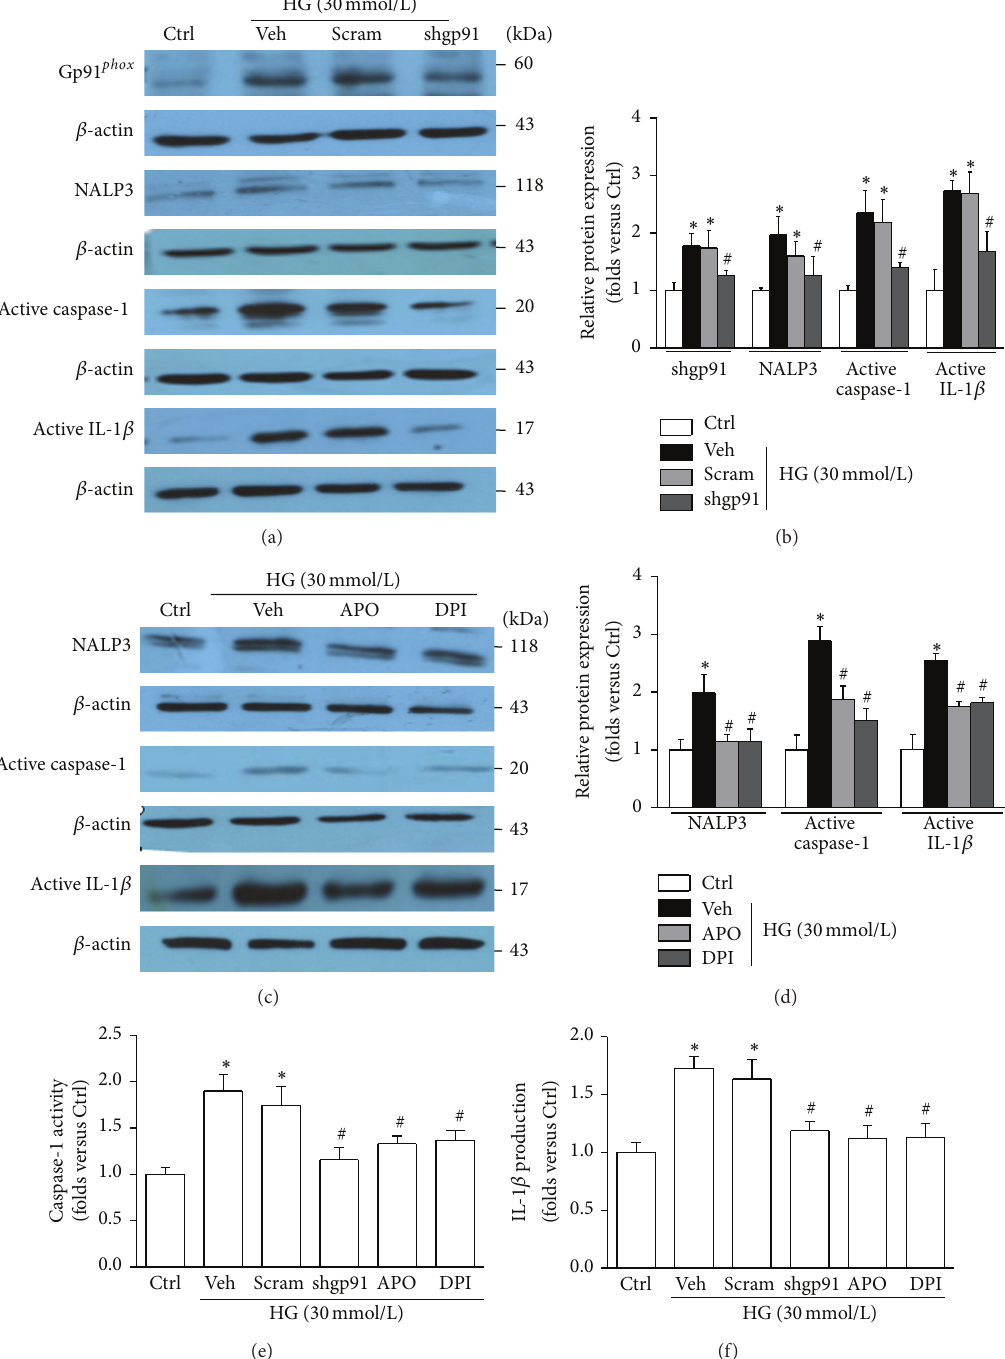
Figure 4: Inhibition of NADPH oxidase attenuates HG-induced NALP3 inflammasome activation and function. (a) Western blot analysis showing the expression of gp 91 𝑝ℎ𝑜𝑥 , NALP3, active caspase-1, and active IL-1 𝛽 in HG-stimulated podocytes without or with gp 91 𝑝ℎ𝑜𝑥 shRNA transfection. (b) Summarized data showing the band intensities measured from gp 91 𝑝ℎ𝑜𝑥 , NALP3, active caspase-1, and active IL-1 𝛽 ( 𝑛 = 6 ). (c) Immunoblotting presenting the expression of NALP3, active caspase-1, and active IL-1 𝛽 in HG-stimulated podocytes without or with treatment of APO or DPI. (d) Summarized data showing the band intensities of NALP3, active caspase-1, and active IL-1 𝛽 ( 𝑛 = 4–8). (e) Caspase-1 activity in podocytes treated with HG in the presence of various genetic and pharmacologic inhibition of NADPH oxidase ( 𝑛 = 5 ). (f) IL-1 𝛽 concentration in the supernatant of podocytes treated with HG in the presence of various genetic and pharmacologic inhibitors of NADPH oxidase ( 𝑛 = 6 ). Ctrl: control; HG: high glucose; Veh: vehicle; Scram: scrambled shRNA; shgp91: gp 91 𝑝ℎ𝑜𝑥 shRNA; APO: apocynin; DPI: diphenyleneiodonium. ∗ 𝑃 < 0.05 compared with Ctrl. # 𝑃 < 0.05 compared with HG group treated with vehicle or transfected with scramble